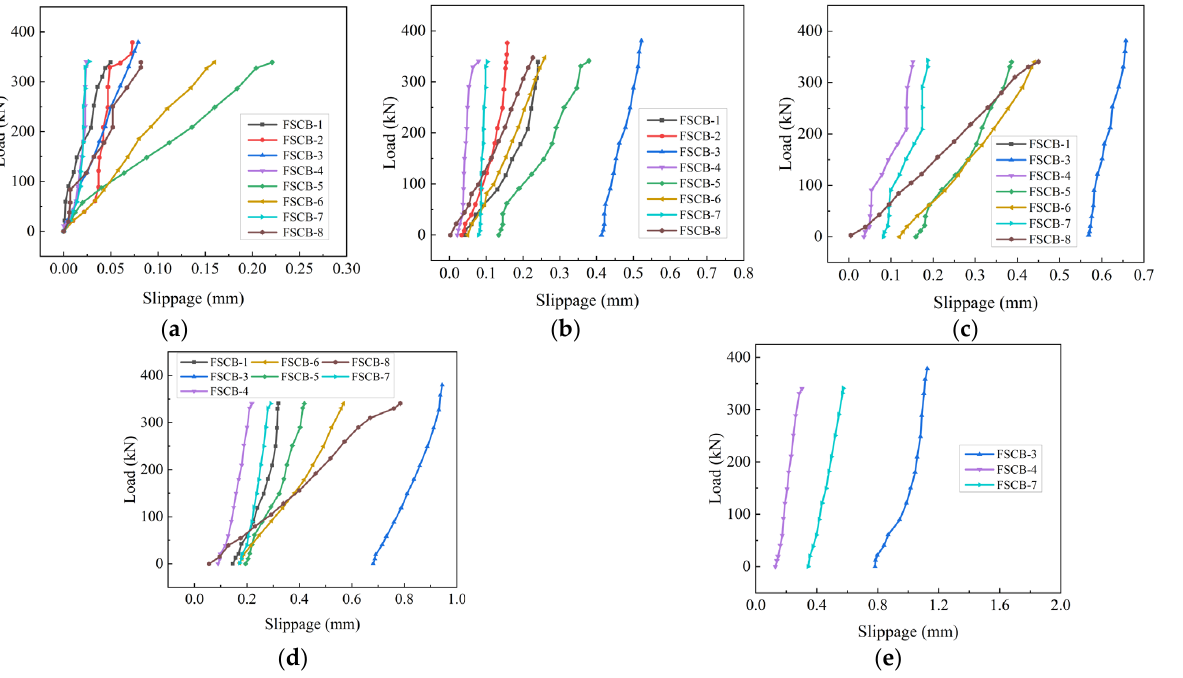
Figure 10. Load–slip curves at a distance of 25 cm from the middle support: ( a ) N c = 0; ( b ) N c = 5.0 × 10 5 ; ( c ) N c = 1.0 × 10 6 ; ( d ) N c = 1.5 × 10 6 ; ( e ) N c = 2.0 × 10 6 .